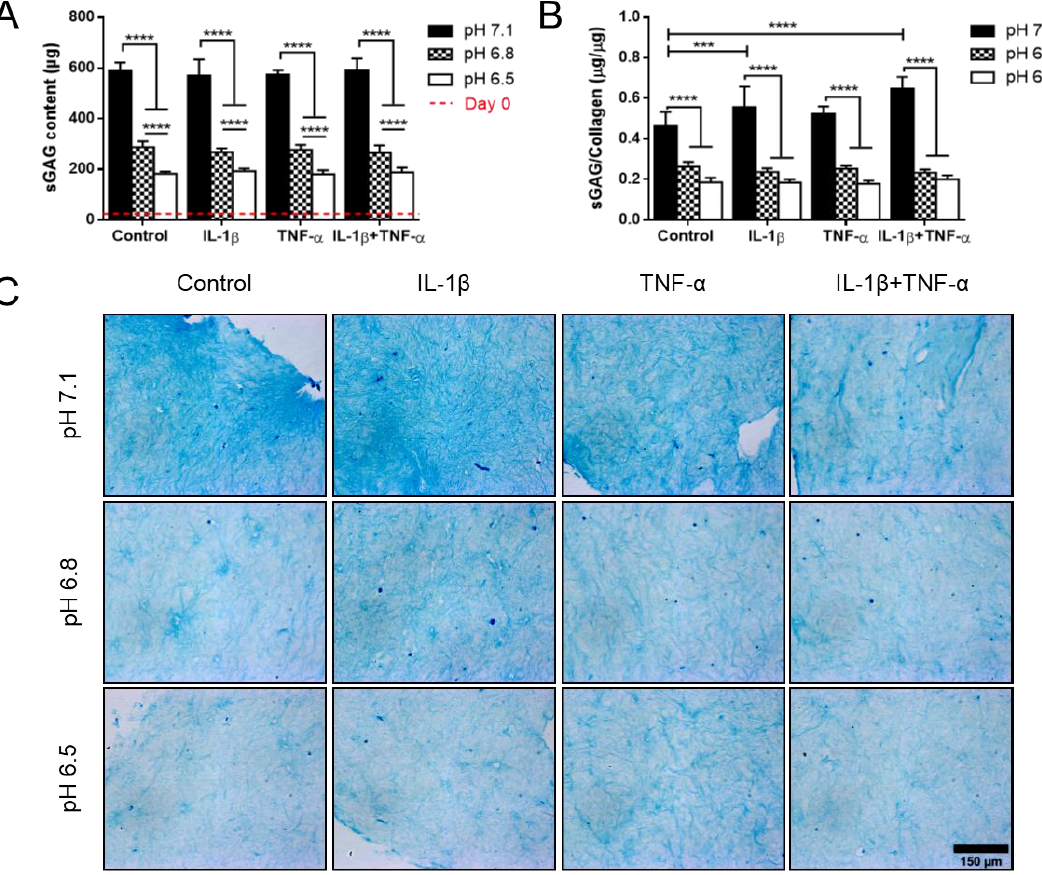
Figure 4. ( A ) Sulphated glycosaminoglycan (sGAG) content ( µ g) in samples (hydrogels + culture media) at day 14 cultured in pH modified media (pH 7.1, 6.8 and 6.5) either unsupplemented (control) or supplemented with IL1- β and TNF- α or a combination of both. Dashed line represents day 0 sGAG content. ( B ) sGAG:Collagen ratio. Both sGAG and collagen were calculated as respective amounts produced over 14 days by subtracting day 0 content from day 14. *** ( p < 0.001) and **** ( p < 0.0001) indicate significant di ff erences between groups. N = 3 donors, n = 3 samples. ( C ) Alcian blue histological evaluation for sGAG accumulation in hydrogels at day 14. Scale bar is 150 µ